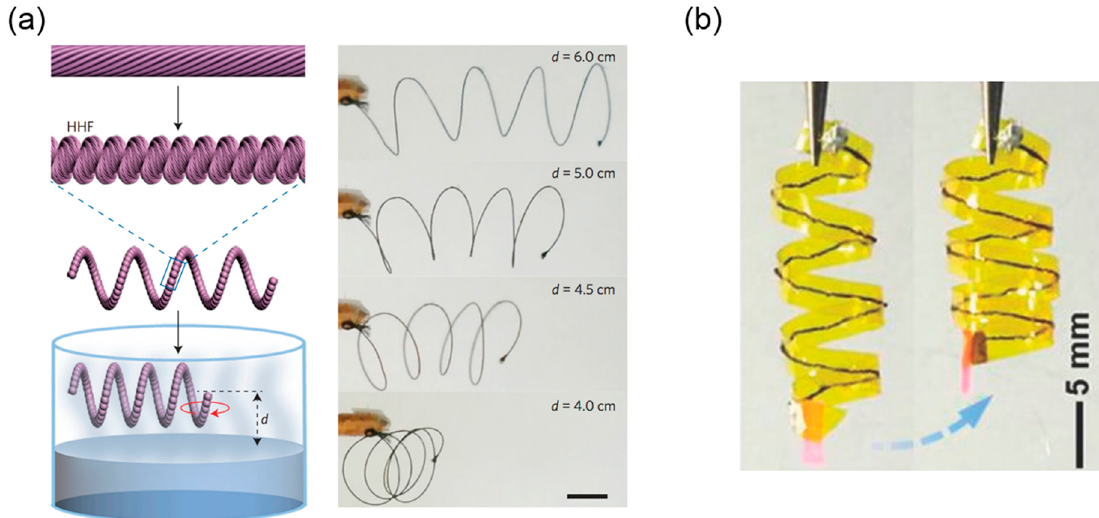
Figure 13. Contractive actuation of the coiled secondary fibers made of MWCNTs under vapor and electric current stimuli. ( a ) The contraction actuation of the hierarchical helical fiber when getting close to the dichloromethane (left: schematic; right: experiments). d is the distance between the spring and liquid surface (scale bar 2 cm); ( b ) Electromechanical contraction actuation of a left-handed Kapton film with HHF inside; ( a) is from [113], reprinted with permission from Nature Publishing Group; ( b ) is from [114], reprinted with permission from 2015 Wiley.